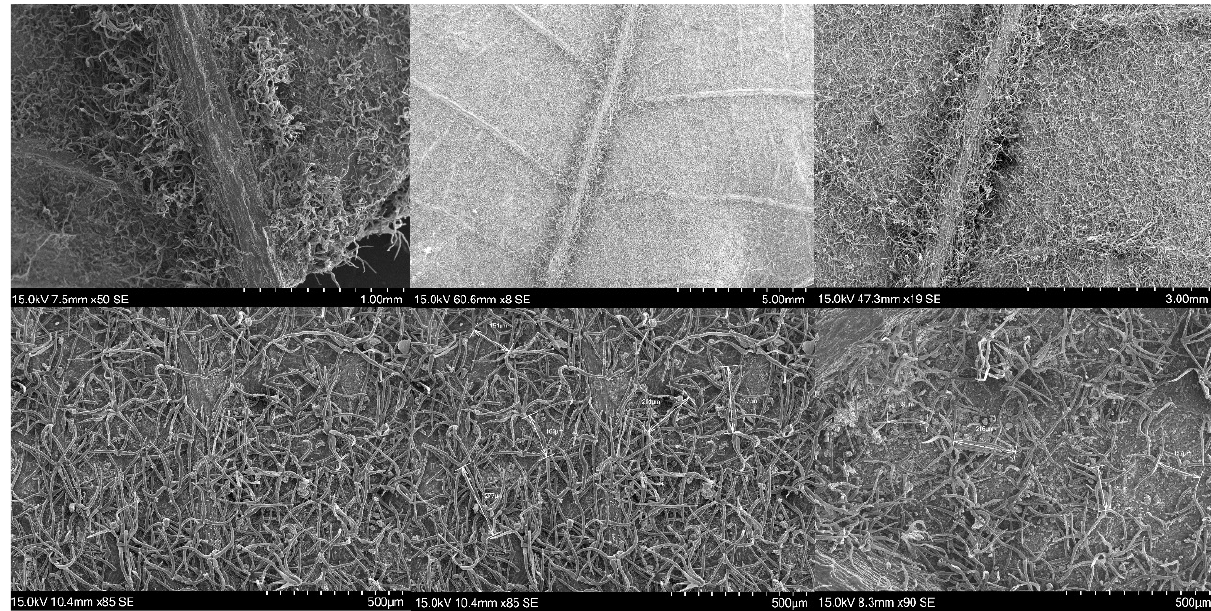
Figure 10. SEM imagery of the abaxial leaf surface, retrieved from the syntype of Q. ×tlemcenensis Trab. from Bouira (Algeria) (P06861505! http://coldb.mnhn.fr/catalognumber/mnhn/p/p06861505). Upper row showing both fuzzy fasciculate indumentum in the midrib, characteristic of Q. canariensis ( Q. mirbeckii ) and the stellate indumentum of Q. faginea on the leaf blade . Bottom row shows detailed images of Q. faginea stellate trichomes with rays up to ca. 280 µm long. 23. Quercus × welwitschii Samp. (1910: 123) non Gandoger nom. illegit. ≡Quercus × neomairei A. Camus (1937: 28) Camus (1938: 408) =Quercus & Franco 1954: 25) ≡ Quercus × andegavensis Hy nothosubsp. henriquesii (Franco & Vasc.)